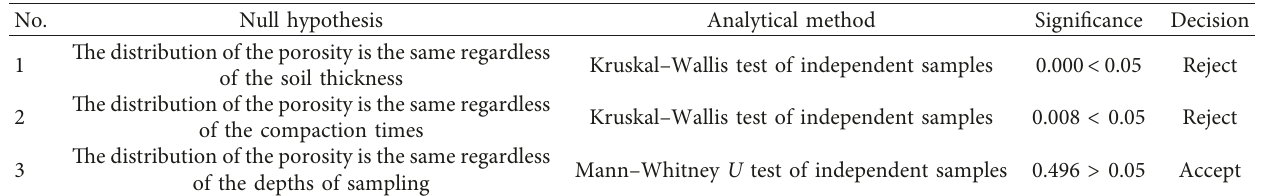
Table 3: Results of the independent sample